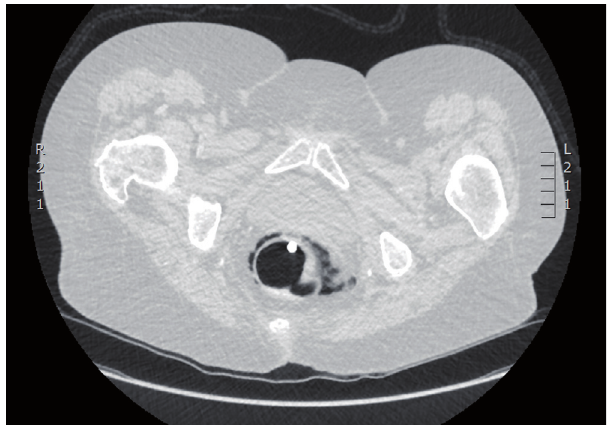
Figure 1. CT colonography depicting contained rectal perforation. The Foley catheter tip is seen in rectum as well as localized peri- rectal air.